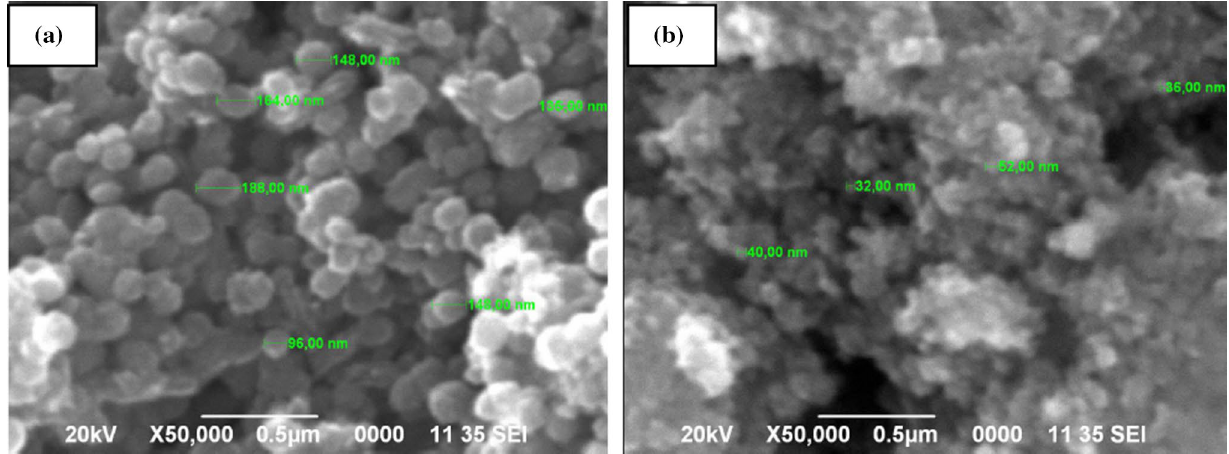
Fig. 3 SEM images of TiO